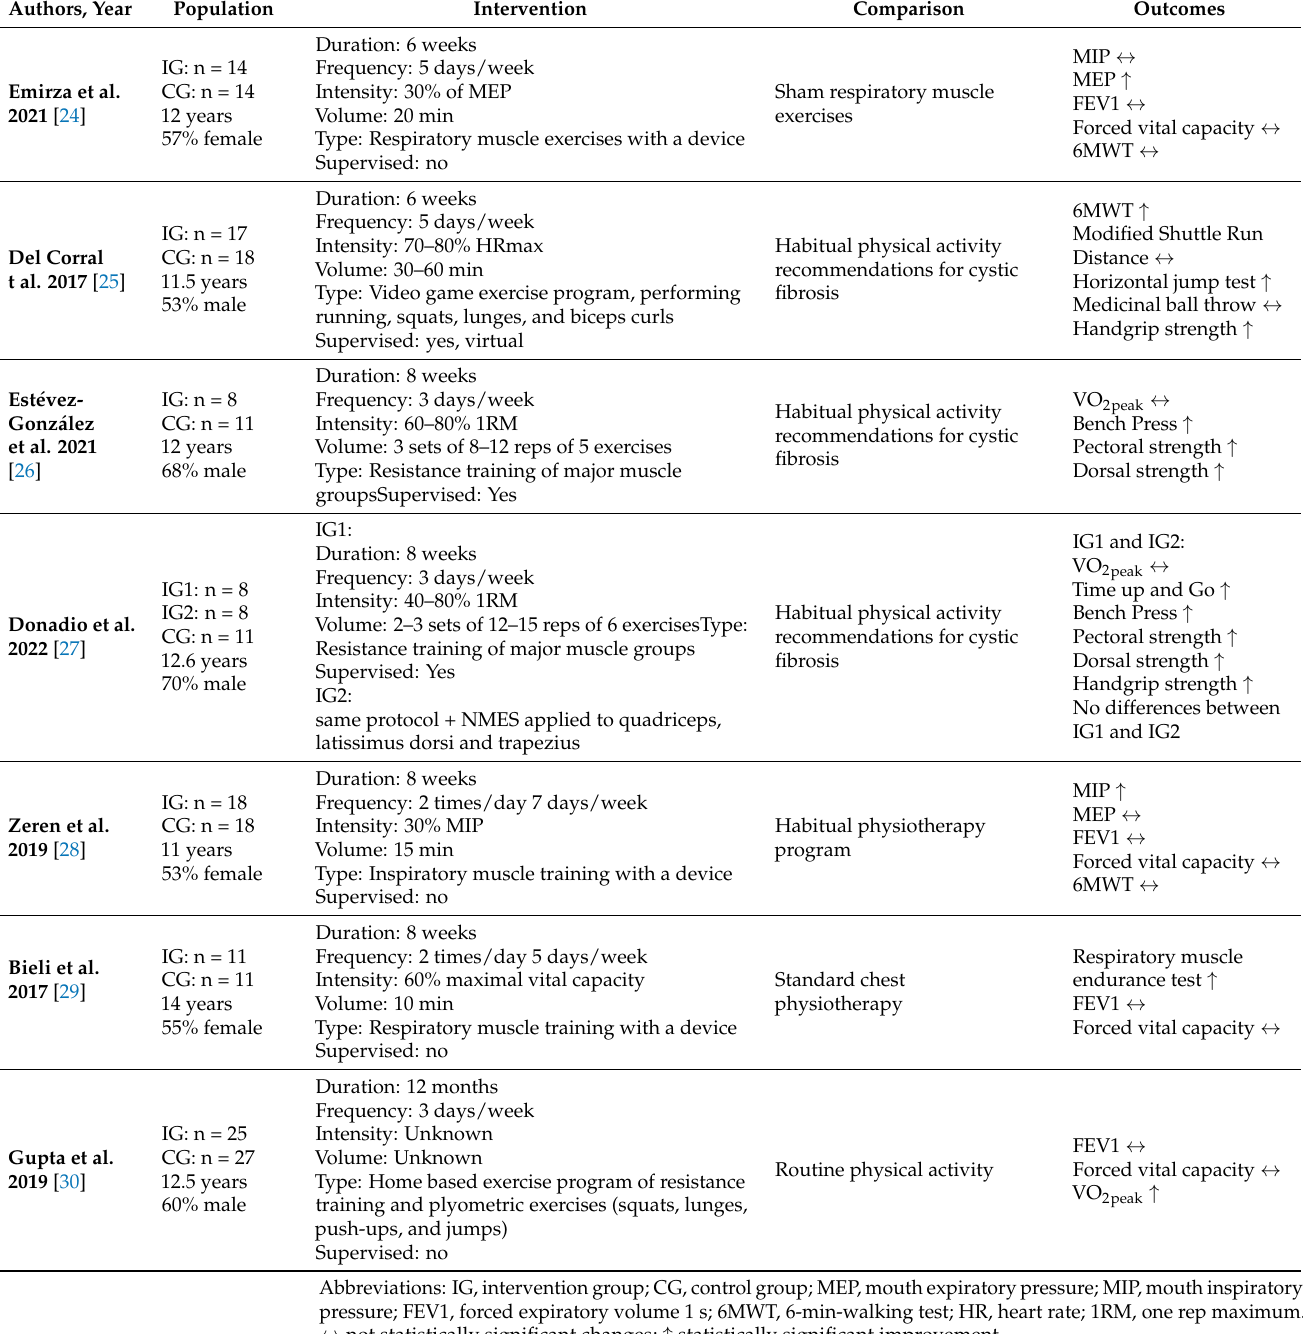
Table 1. Outcomes from physical exercise interventions on children with cystic